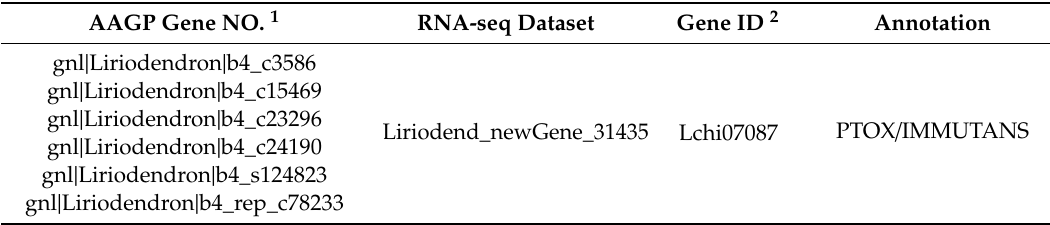
Table 1. Screening and identification of LtuPTOX from multiple Liriodendron